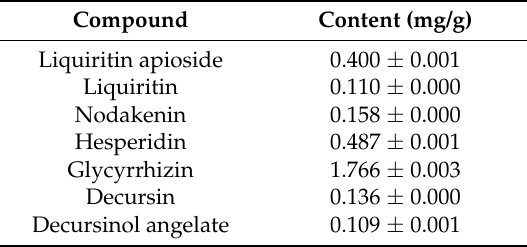
Table 2. The content of standard compounds in